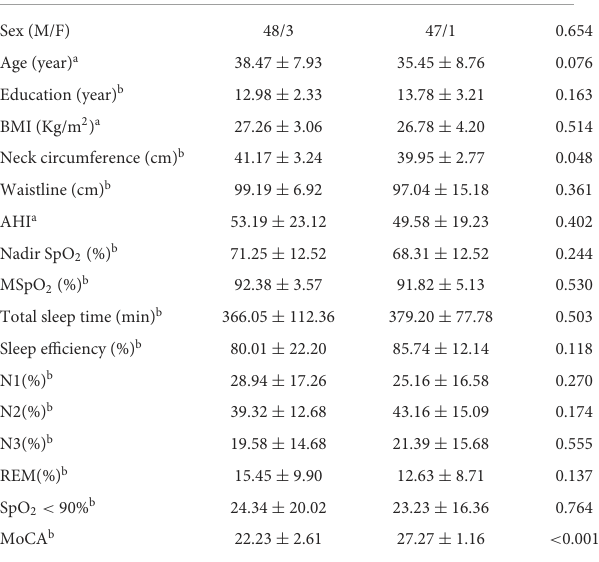
TABLE 1 General clinical scale.